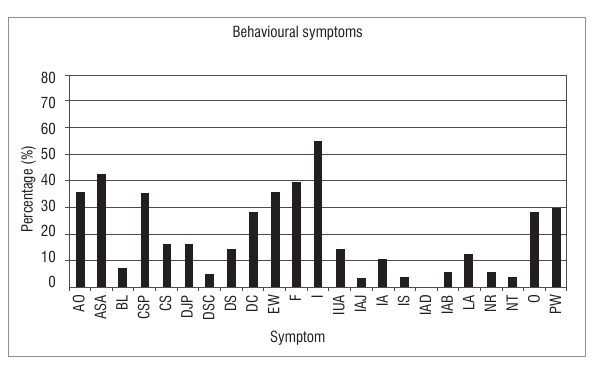
Figure 2: Percentage of educators that indicated the presence of specific emotional symptoms of stress over the 6 months preceding the study.